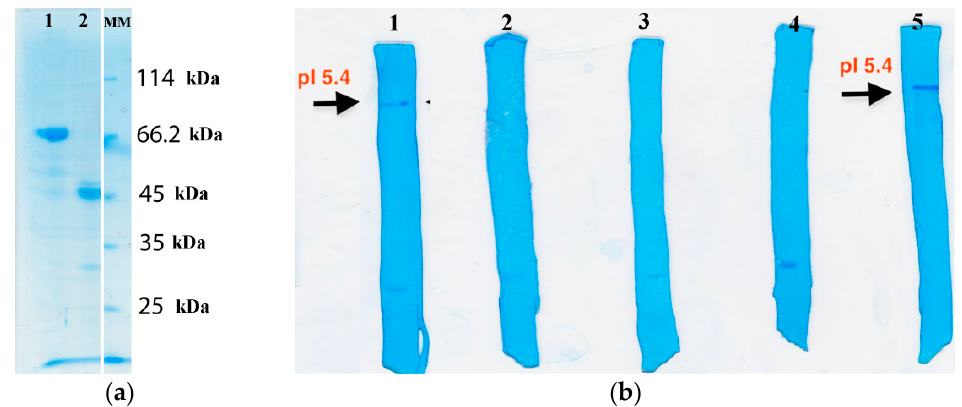
Figure 2. ( a ) SDS ‐ PAGE electrophoresis of: 1—commercial HRP before purification; 2—HRP ‐ C isoform; MM—Molecular weight markers. ( b ) Isoelectric focusing and pI values of HRP isoforms: 1—commercial HRP before purification; 2–4—basic isoforms; 5—HRP ‐ C isoform.